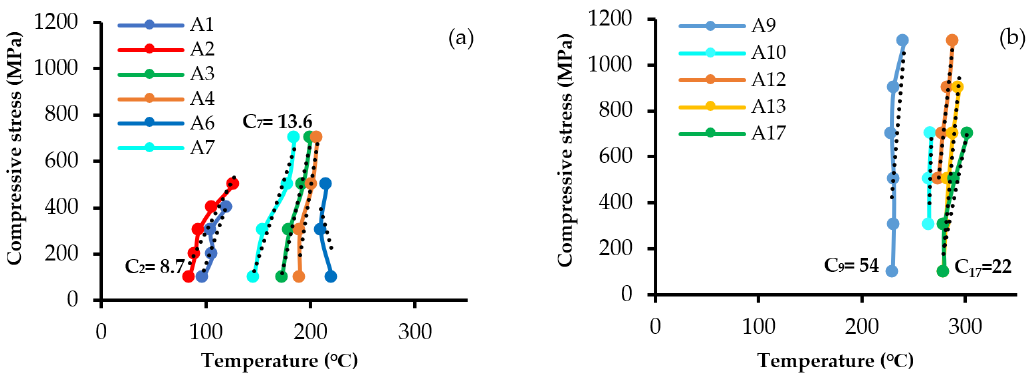
Figure 11. Martensite start temperature (M s ) vs. compressive applied stress: ( a ) LE samples, and ( b ) HE samples.